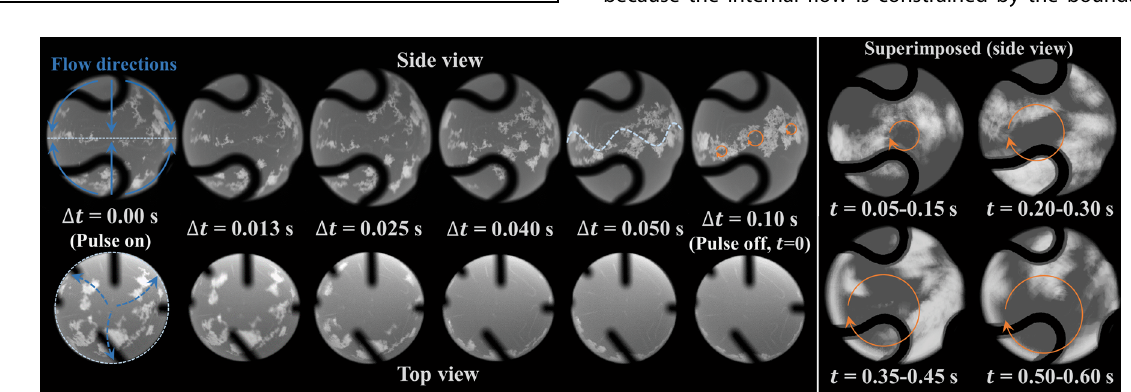
Fig. 7 The images of an electromagnetically levitated droplet (CMSX-10). The fl ow pattern and velocity were traced by the impurity particles on the droplet surface during and after the pulse